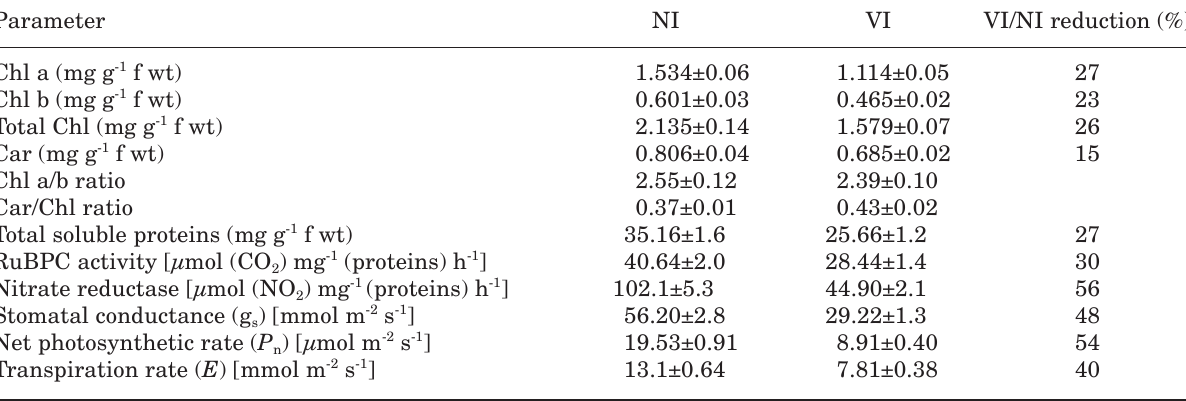
Table 1. Photosynthetic pigments, net photosynthetic rate ( P soluble proteins, RuBPC and nitrate reductase activity in noninfected (NI) and virus-infected (VI) leaves. Values are means ±SE, ( n =5). Percent reduction of VI compared to NI plants (mean ±SE; n =5) for each parameter is also